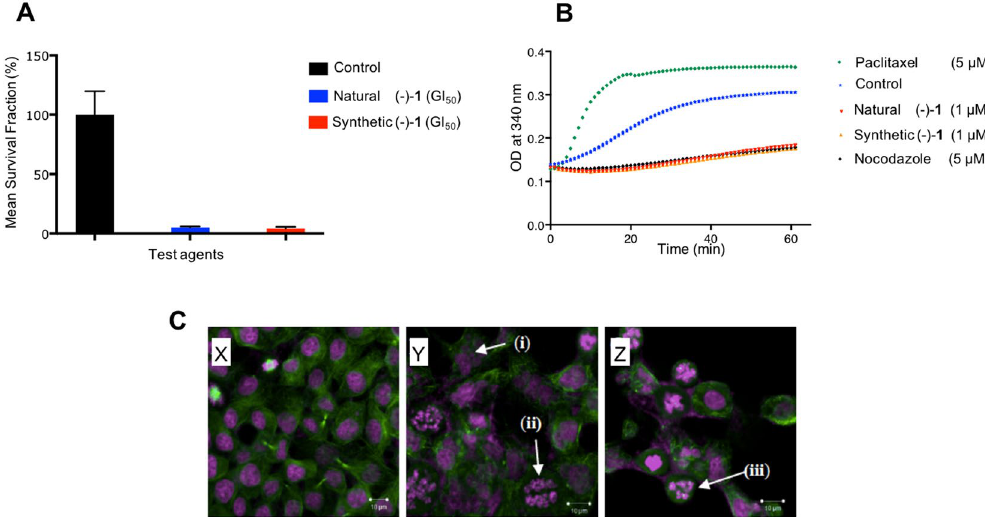
Figure 3. ( A ) Effect of natural and synthetic 1 on HCT-116 colony formation at GI 50 (see Table 1). Mean survival fraction (%) of treated cells as a percentage of the control population for HCT-116. Cells were seeded (400 per well) and allowed 24 h to attach before being challenged with jerantinine A (24 h). The number of colonies forming after 8 d incubation was determined. Mean ( ± S.E.M.) values are given. Data were generated from ≥ 3 separate trials; n = 2 per trial; ( B ) In vitro tubulin polymerisation in the presence of vehicle control, paclitaxel (5 μ M; positive control), nocodazole (5 μ M; negative control) or 1 (1 µ M); ( C ) Immunofluorescent and DRAQ5 staining of x) untreated MCF-7 cells and y-z) cells exposed to synthetic 1 (1 × GI 50 = 0.81 μ M; 24 h), showing the effect on microtubules (green) and the cellular DNA (purple). Synthetic ( − )-jerantinine A ( 1 ) caused multinucleation (i), nuclear fragmentation (ii) and formation of multipolar spindles (iii).